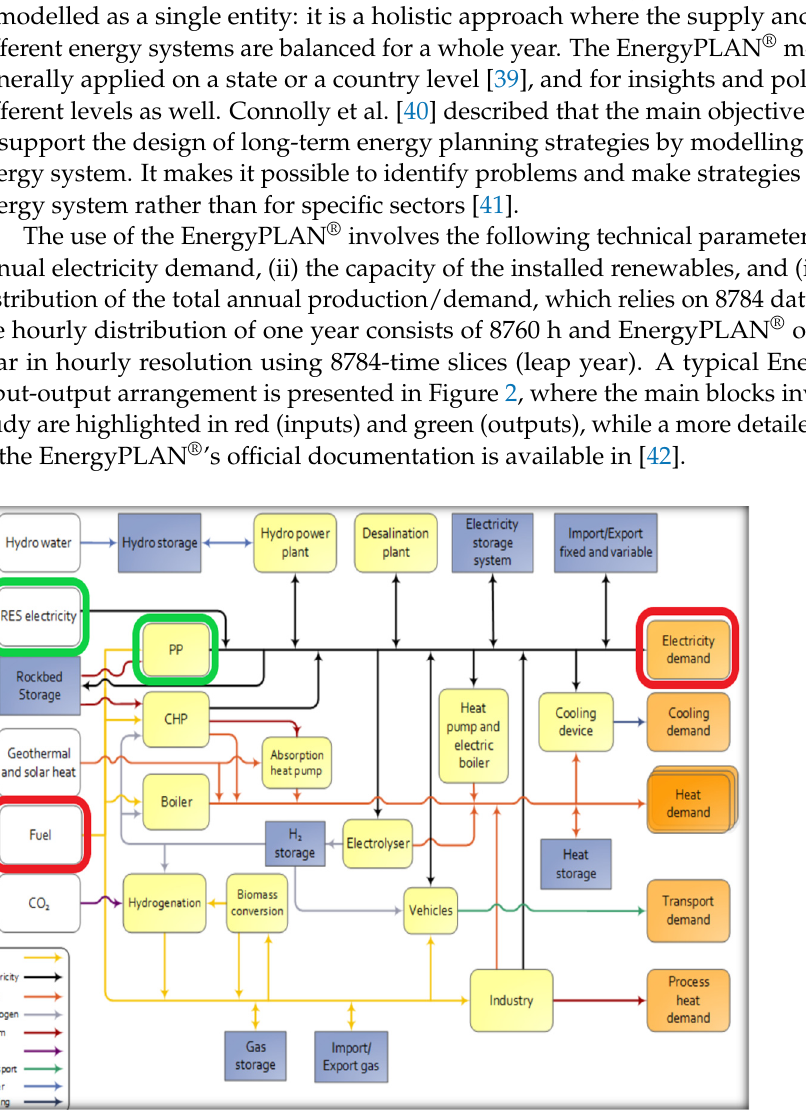
Table 2. Characteristics of the EVs involved in the current study. Size of Vehicle